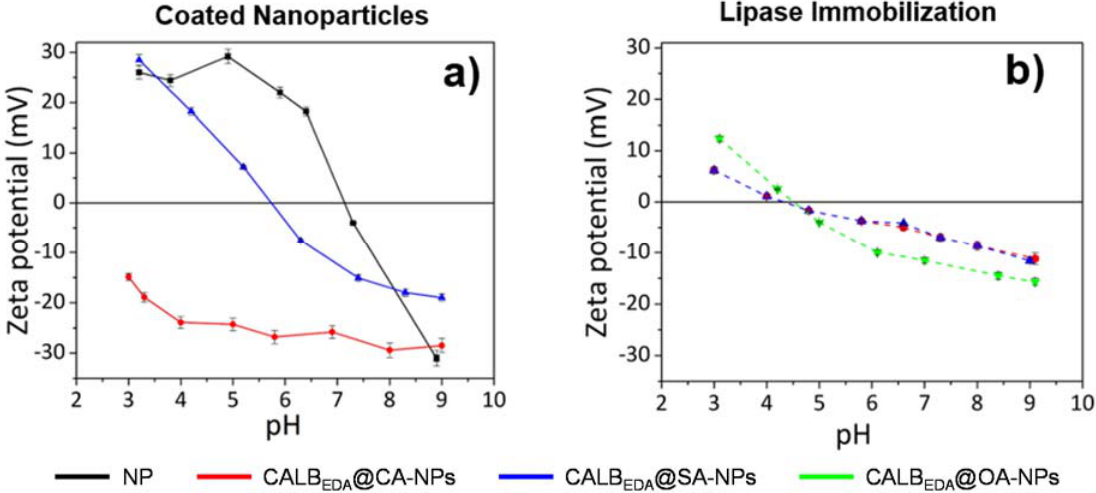
Figure 1. Zeta potential values vs. pH of ( a ) CA and SA coated NPs compared with uncoated NPs and of ( b ) CALB EDA @CA-NPs, CALB EDA @SA-NPs and CALB EDA